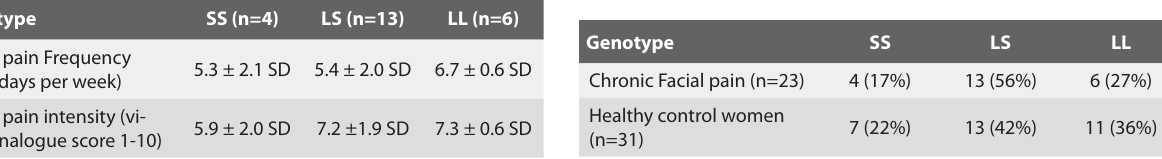
Table 7. Number and percentage of women with chronic pain and female controls having the SS, LS or LL genotype (the difference is not significant, chi squared test p=0.6)